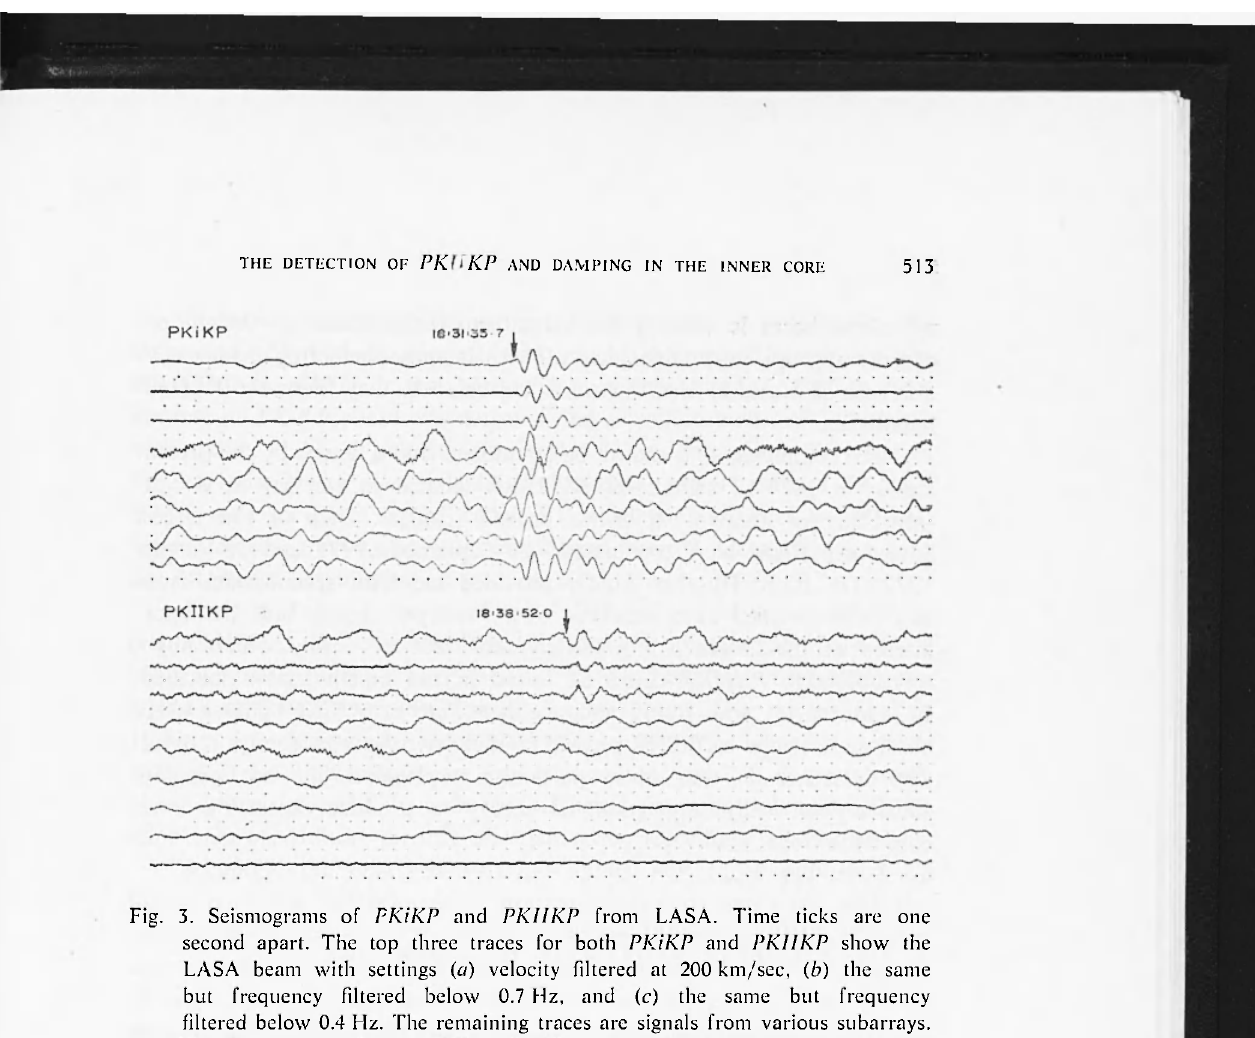
Fig. 3. Seismograms of PKiKP and PKIIKP from LASA. Time ticks are one second apart. The top three traces for both PKiKP and PKIIKP show the LASA beam with settings (a) velocity filtered at 200 km/sec, (b) the same but frequency filtered below 0.7 Hz, and (c) the same but frequency filtered below 0.4 Hz. The remaining traces arc signals from various subarrays. The beam azimuths are 230° and 50°,